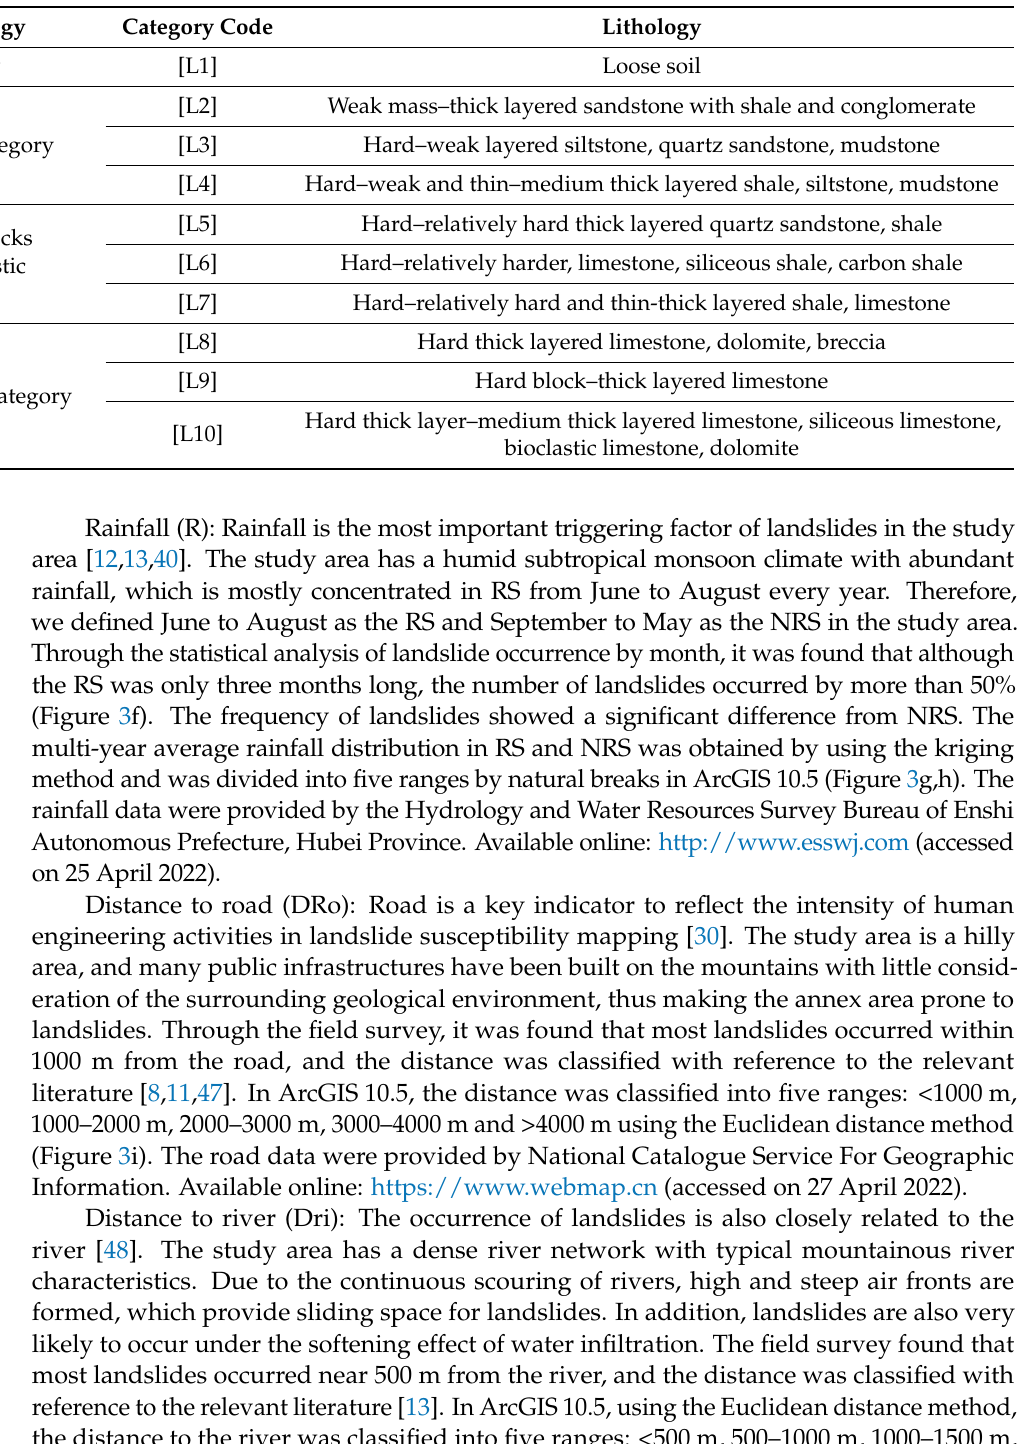
Table 1. The categories of lithology in the study